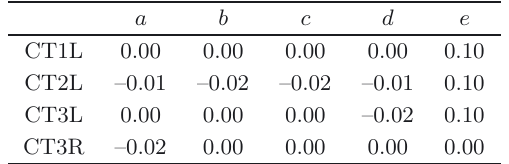
Table 9. Control Matrix C (cid:2) .